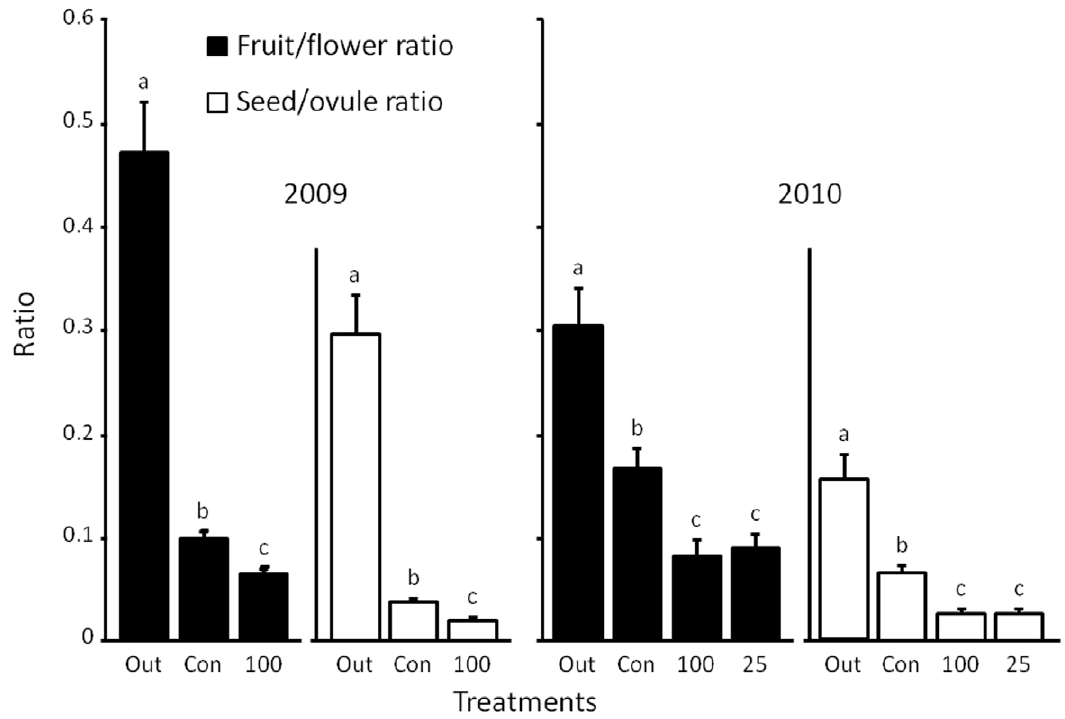
Figure 3. Comparison of the fruit/flower and seed/ovule ratios among the three treatments in 2009 and the four treatments in 2010. Letters indicate differences in the fruit/flower and seed/ovule ratios as determined by AICs depending on GLMMs. ‘‘Out’’ indicates the outcross-pollination treatment, ‘‘Con’’ denotes the control experiment, ‘‘100’’ denotes the flower visitor barrier experiment with a 100-mm mesh, and ‘‘25’’ refers to the flower visitor barrier experiment with a 25-mm mesh. doi:10.1371/journal.pone.0033803.g003 PLoS ONE |